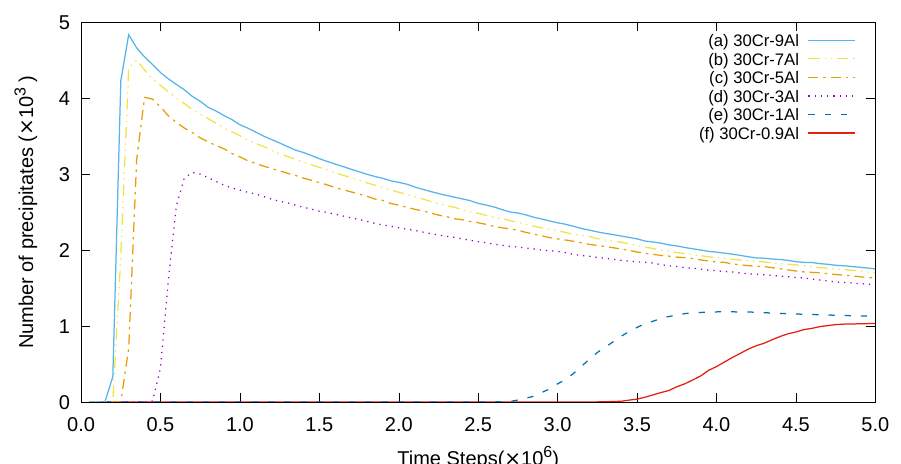
Figure 3. Number density of the α (cid:48) precipitates per cell size of the 2D simulation at an average Cr concentration of 30% when the average Al concentration was ( a ) 9%, ( b ) 7%, ( c ) 5%, ( d ) 3%, ( e ) 1%, and ( f ) 0.9%. Overshooting was observed before t ∗ = 1.0 × 10 6 in ( a – d ).